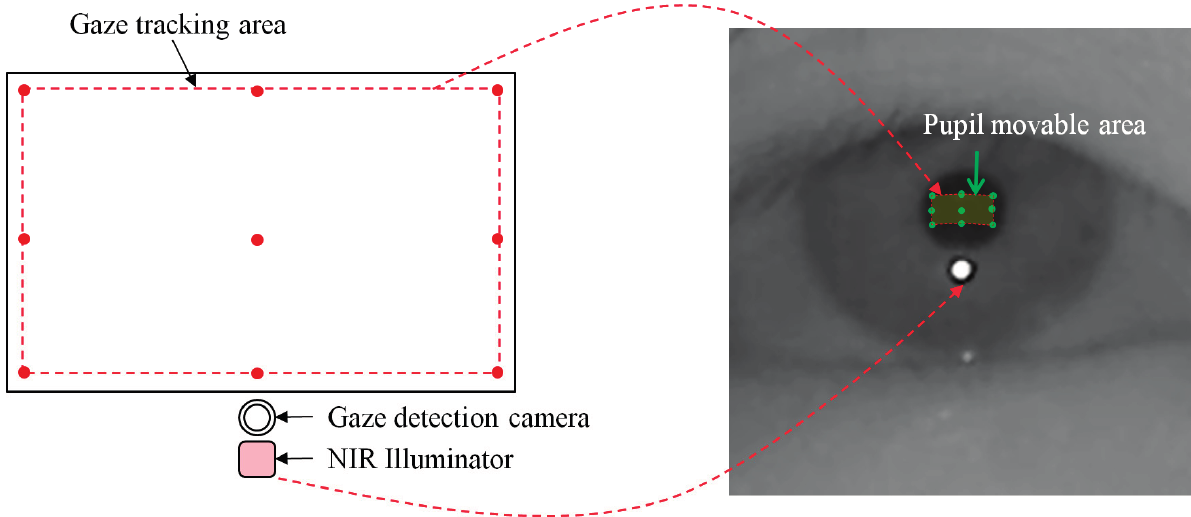
Figure 11. Nine pupil centers which are obtained when a user gazes at nine calibration points.